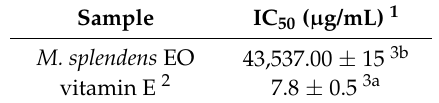
Table 4. Antioxidant activity of M. splendens essential oil compared with the standard (vitamin E).